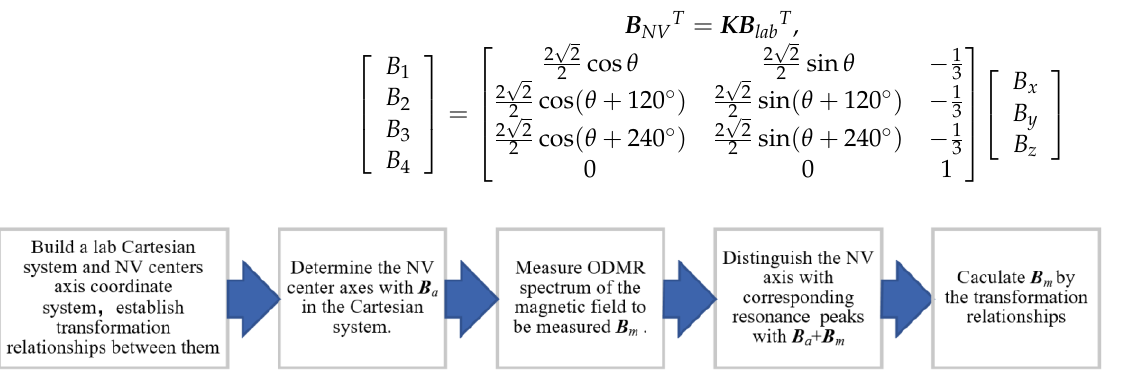
Figure 6. Measurement steps of vector static magnetic field.